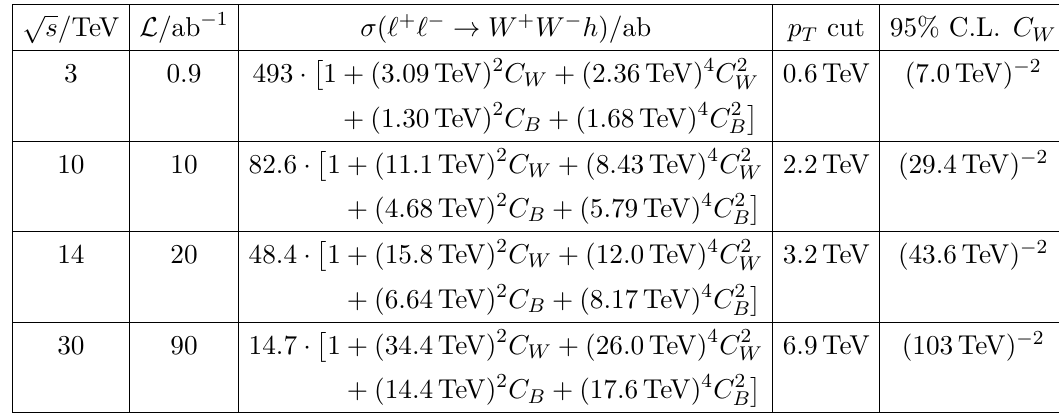
Table 5 . Fiducial ‘ + ‘ − → W + W − h cross-section at high energy lepton colliders. The fiducial phase-space is defined by the cuts on the p T of the Higgs and hardest W specified in the fourth column. We also show the 95% C.L. symmetrized bound on C W , from this measurement alone.